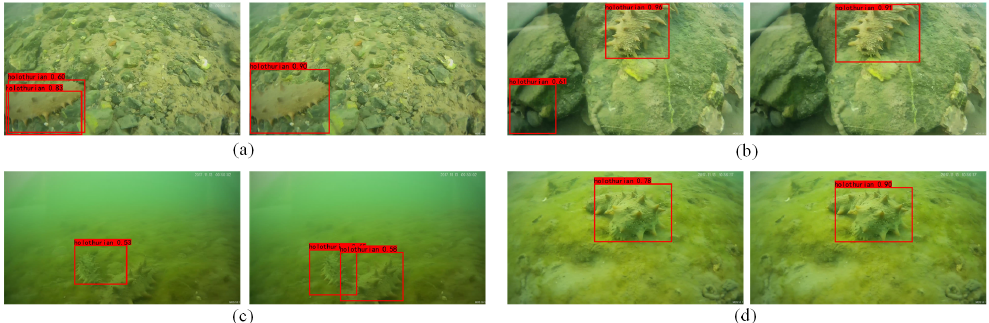
Figure 12. Comparison of sea cucumber identification before and after model